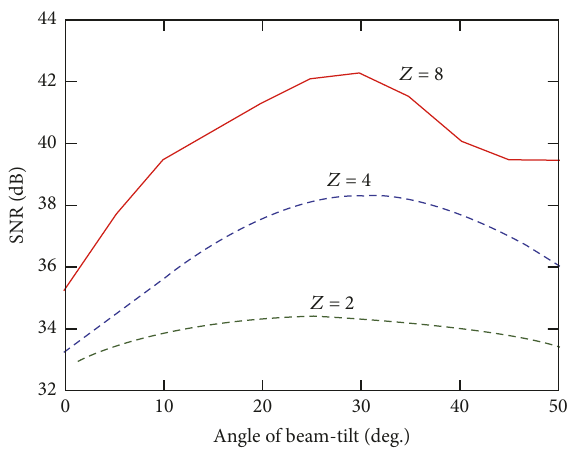
Figure 9: SNR versus angle of beam-tilt.